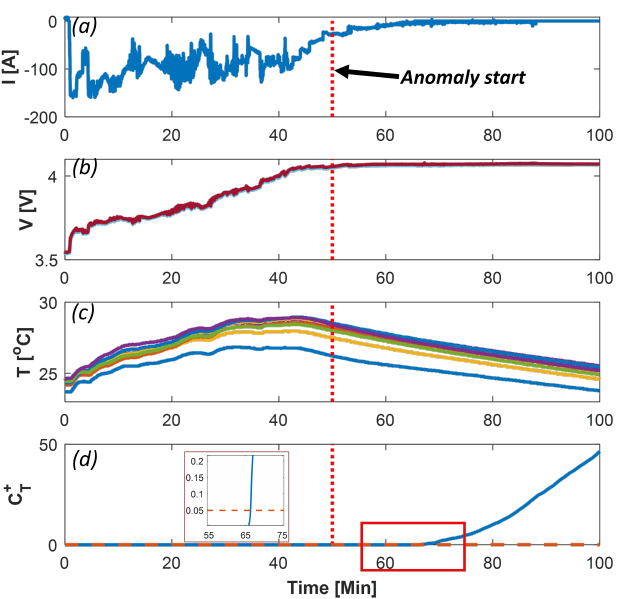
Figure 9. Detection using PCA method on experimental data with ESC in all cells initiated at 50 min (vertical dotted): ( a ) Pack current; ( b ) Voltage of 11 cells; ( c ) Temperature of 11 cells; ( d ) C + threshold (dashed).